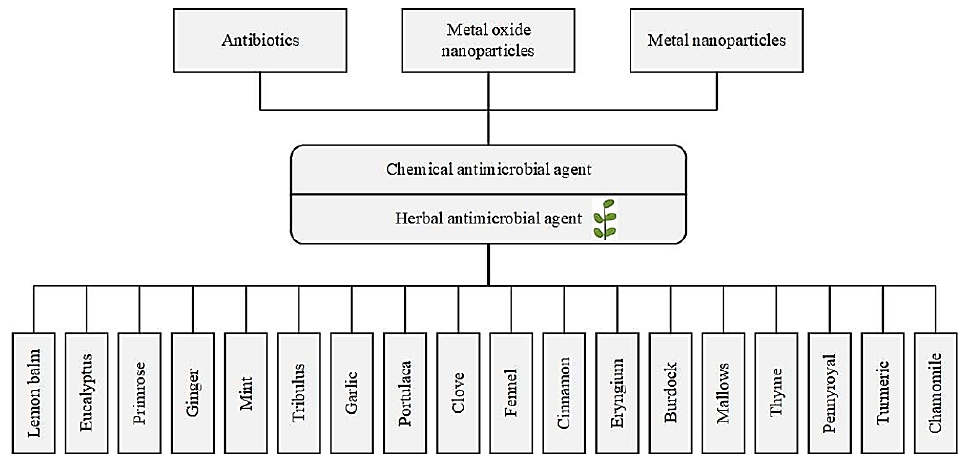
Figure 3. The antimicrobial agents’ classification based on their different substances.